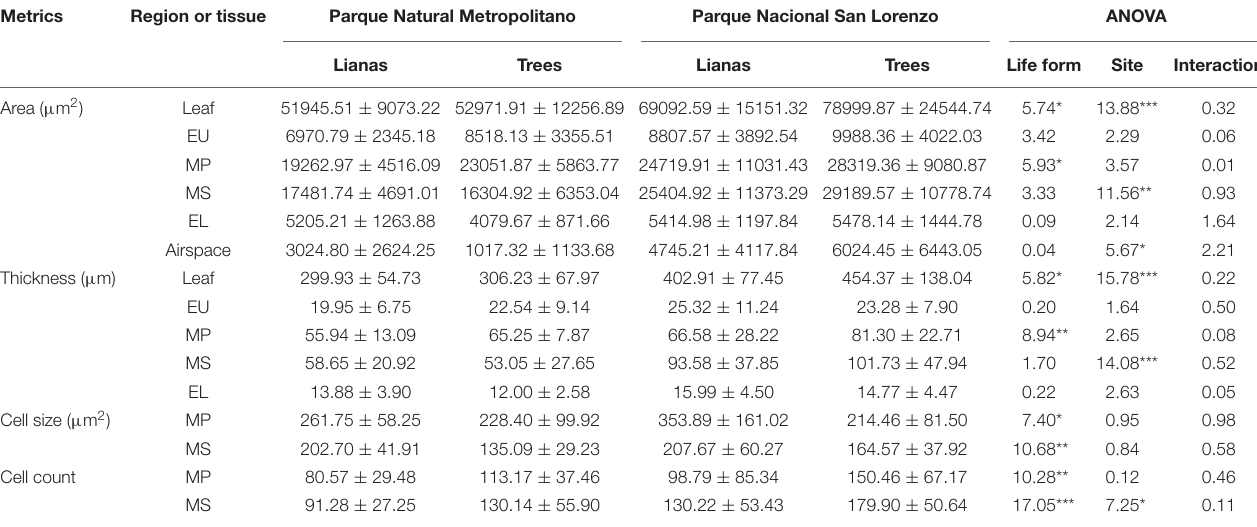
TABLE 4 | Comparison of anatomical metrics between lianas and trees summarized by forest type: seasonally dry forest (Parque Natural Metropolitano) and wet forest (Parque Nacional San Lorenzo). Metrics Region or